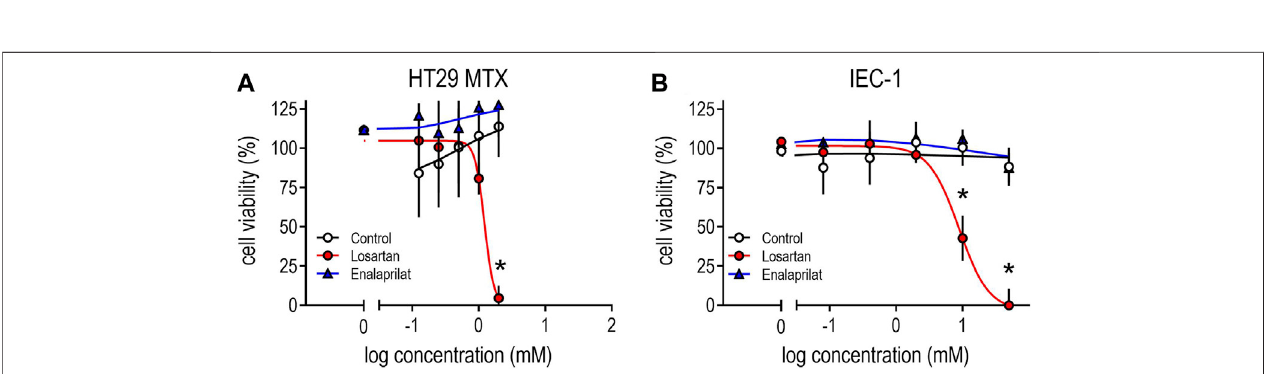
FIGURE7| Effectsoflosartanorenalaprilatoncellviabilityinmucus-producingHT29-MTXcells (A) ;(IC 50 1.2 mM)orinmurineintestineepitheliumcells (B) ;(IEC-1; IC 50 8.8 mM). TritonX100 (0.5%) served as a control for total cell death. Cell viability was measured by using a commercial MTS assay after incubating cells for 8 days (HT29-MTX) or 3 days (IEC-1) with losartan (0.08 – 50 mM) or enalaprilat (0.1125 – 2 mM). Means ± SD; (n = 5), * p < 0.05 vs. corresponding controls.